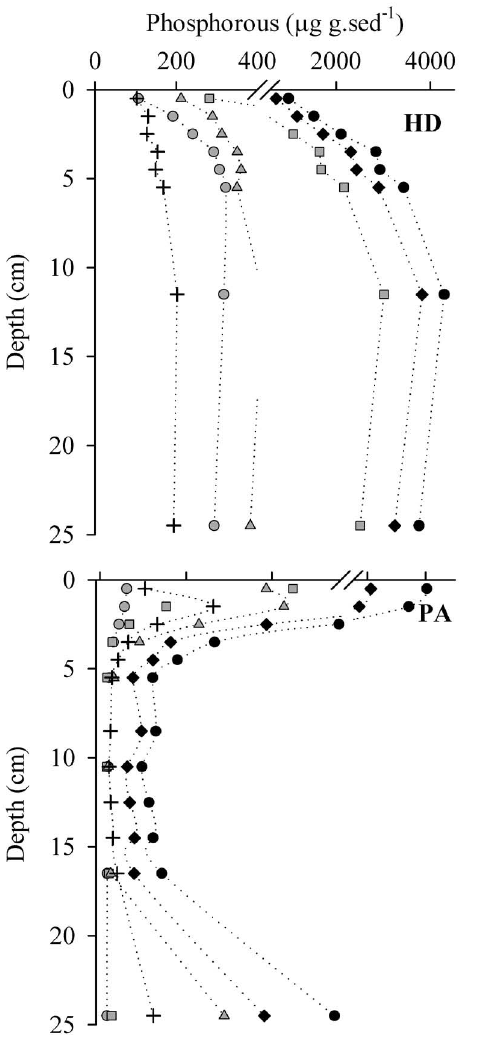
Fig . 5. – Examples of sediment profiles of the different fractions of phosphorus at stations HD and PA. Fig . 6. – Distribution of different phases of phosphorus in surface sediment (0-10 cm) (total phosphorus, shown in upper left